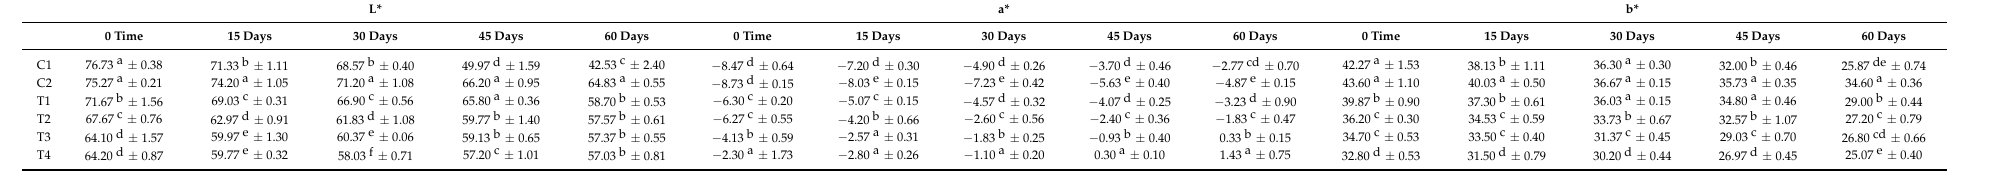
Table 13. Changes in mayonnaise samples’ L*, a*, and b* values enriched with RCFE during storage.